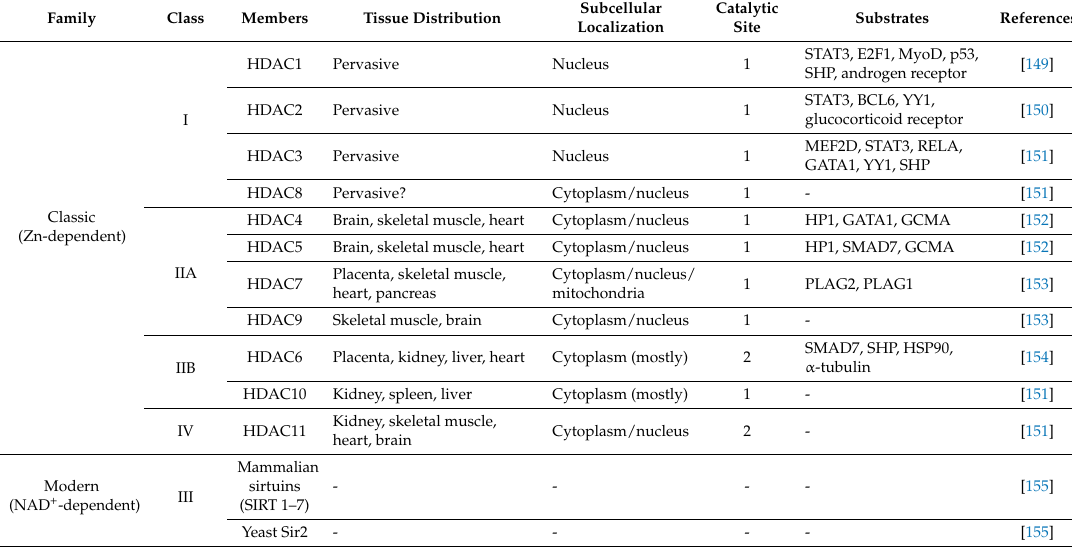
Table 4. HDAC family members and their